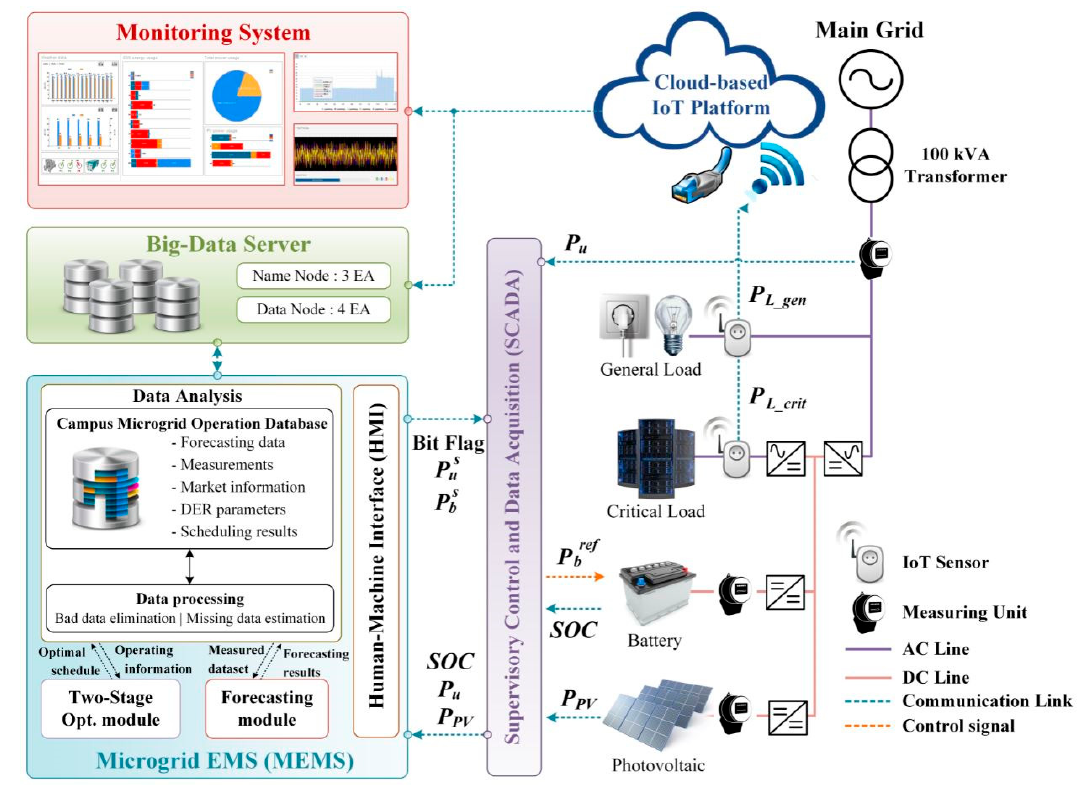
Figure 2. Configuration of the implemented campus MG.